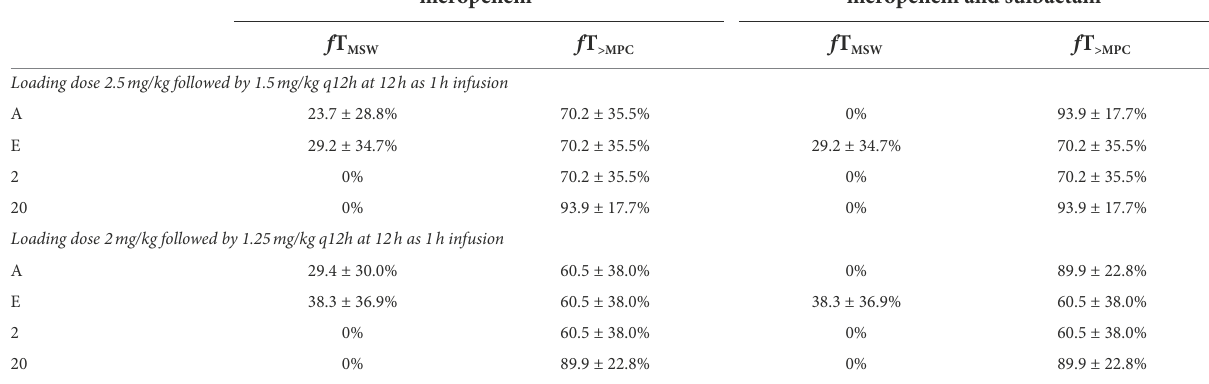
TABLE 6 Pharmacodynamic parameters f T MSW and f T >MPC based on MIC and MPC of polymyxin-B in plasma against four A. baumannii isolates harboring OXA-23 and other serine- β -lactamases. Bacteria